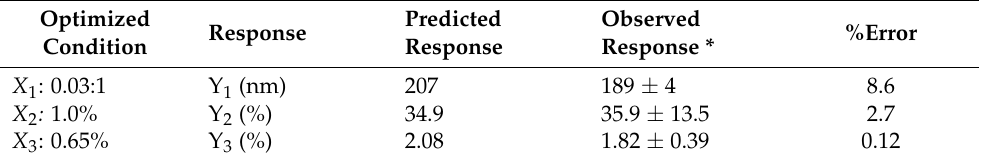
Table 3. Validation of the prediction capability of the RSM